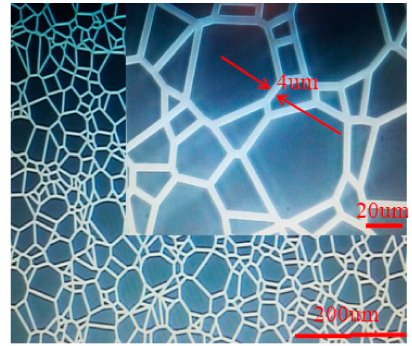
Figure 2. An enlarged photograph showing the pattern of a prepared mask.